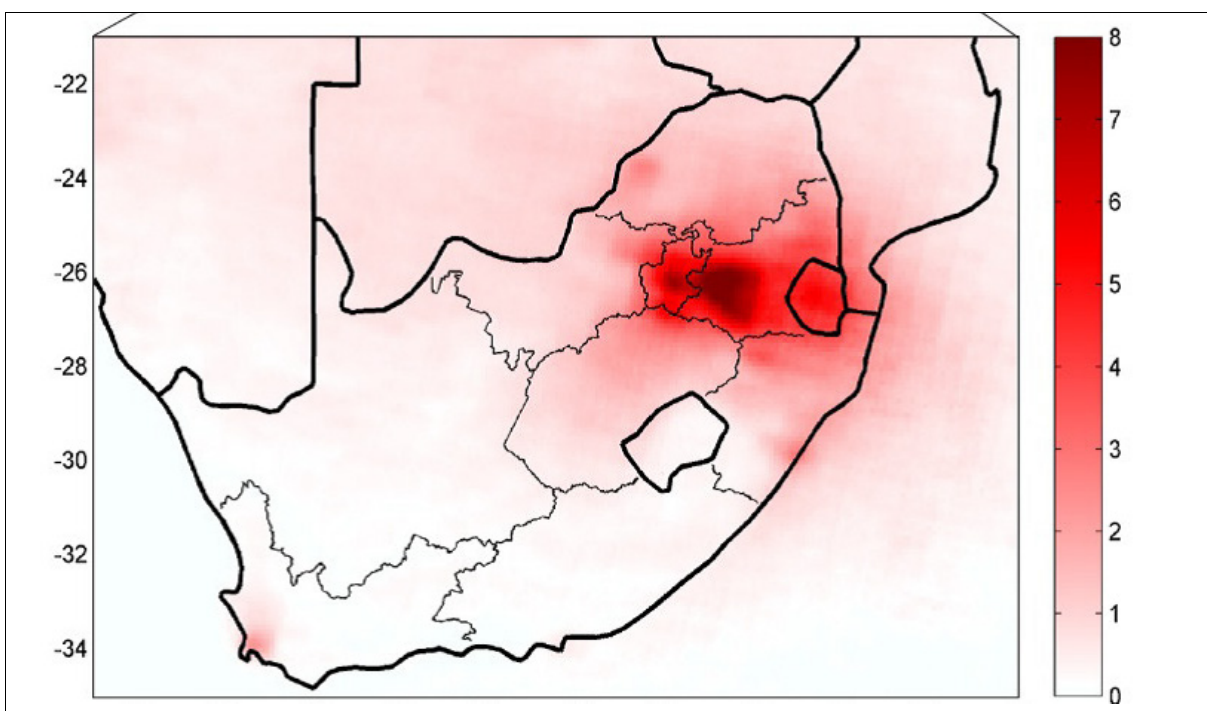
column over the Highveld of South Africa. 2